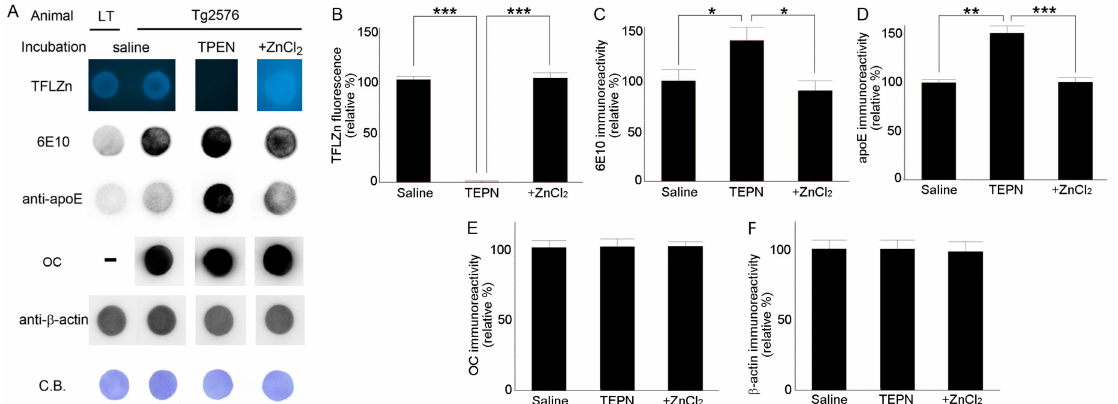
Figure 2. Dot blot analyses of A β and apoE in whole brain lysates from Tg2576 mice. Dot blot analyses of A β and apoE in whole brain lysates from Tg2576 mice. ( A ) Lysate-loaded (80 µ L) membranes were incubated in saline, 100 µ M TPEN, or 100 µ M TPEN followed by 100 µ M ZnCl2, stained with TFLZn, and then reacted with anti-A β (6E10 or OC), anti-apoE or anti- β -actin antibody. Coomassie Blue staining (C.B.) was used as a loading control. ( B–F ) Quantitative analyses of results shown in ( A ). Bars denote the percentage of integrated optical density relative to that of the control saline treatment. Measurements were performed in triplicate using brain lysates of the same Tg2576 mouse. * p < 0.05, ** p < 0.01, and *** p < 0.001 by one-way